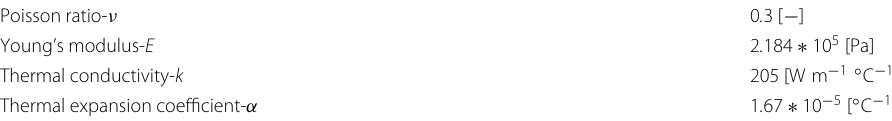
Table 1 Material properties